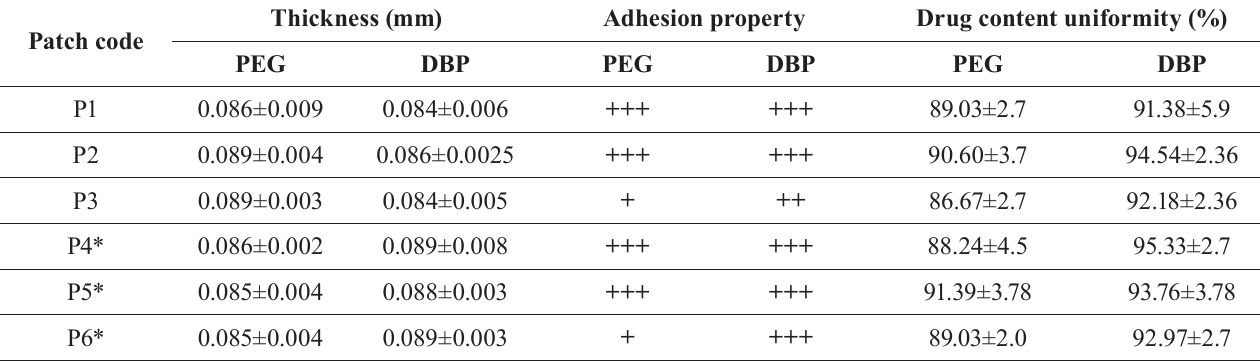
TABLE VI - Thickness, adhesion property and content uniformity of different patches ( n=3 )